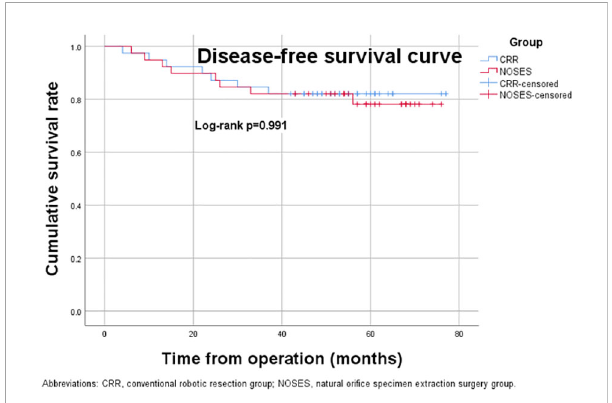
FIGURE 4 Disease-free survival curve. CRR, conventional robotic resection group. NOSES, natural ori fi ce specimen extraction surgery